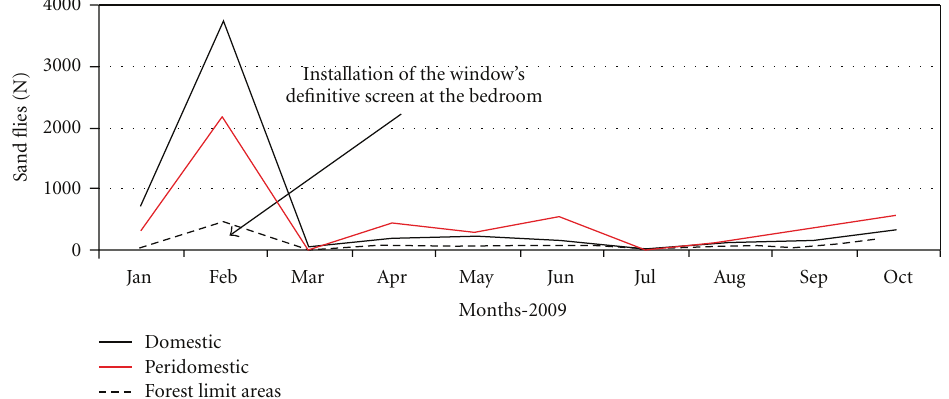
Figure 5: Environmental modifications and monthly capture of sand flies vectors in domestic, peridomestic, and forest limit areas of house 3, January to October